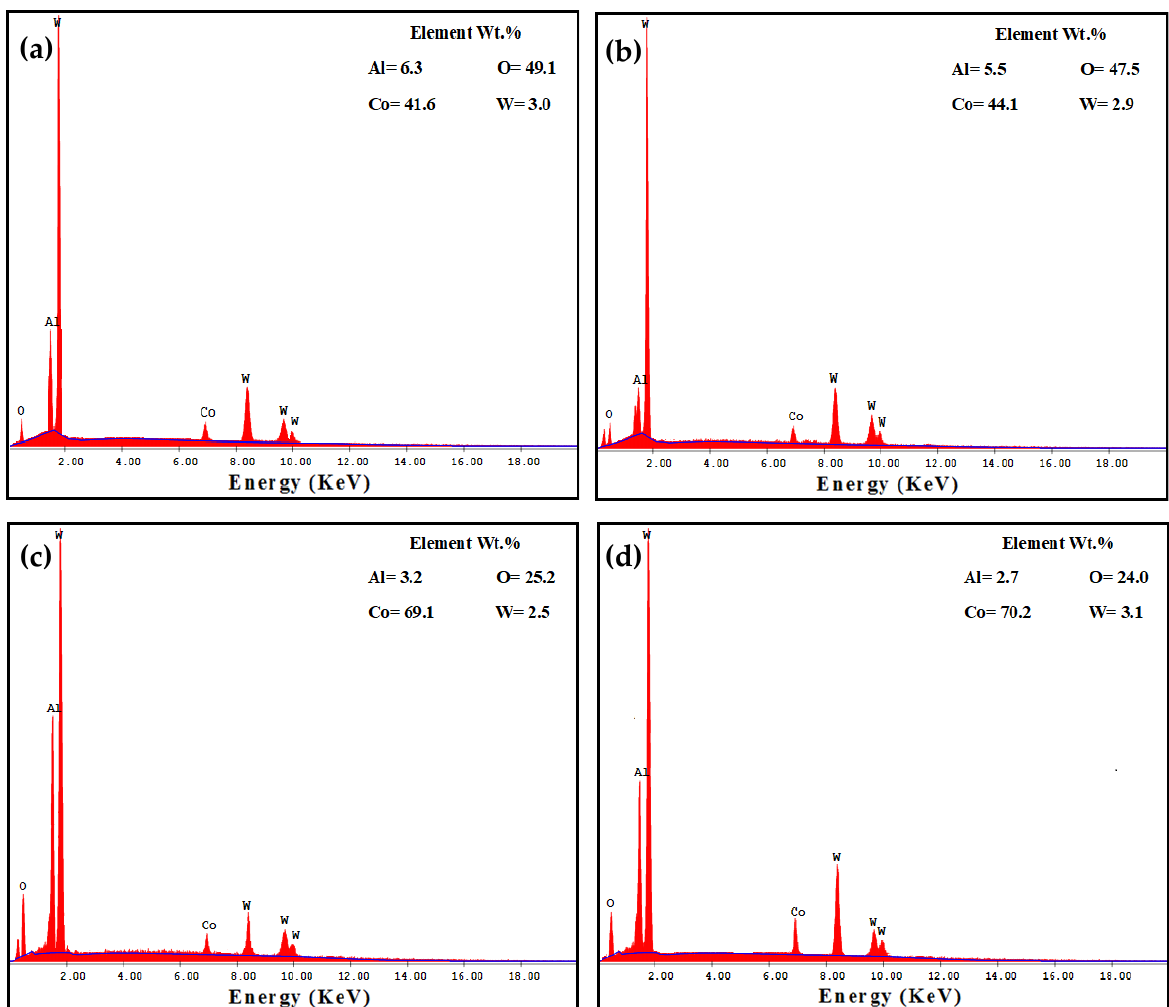
Figure 16. EDS analysis of the WC ball after the sliding against ( a ) PM Al-20% Al 2 O 3 , ( b ) PM Al-20% SiC, ( c ) HPT-processed Al-20% Al 2 O 3 and ( d ) HPT-processed Al-20% SiC samples under an applied load of 20 N and a sliding distance of 1260 m.